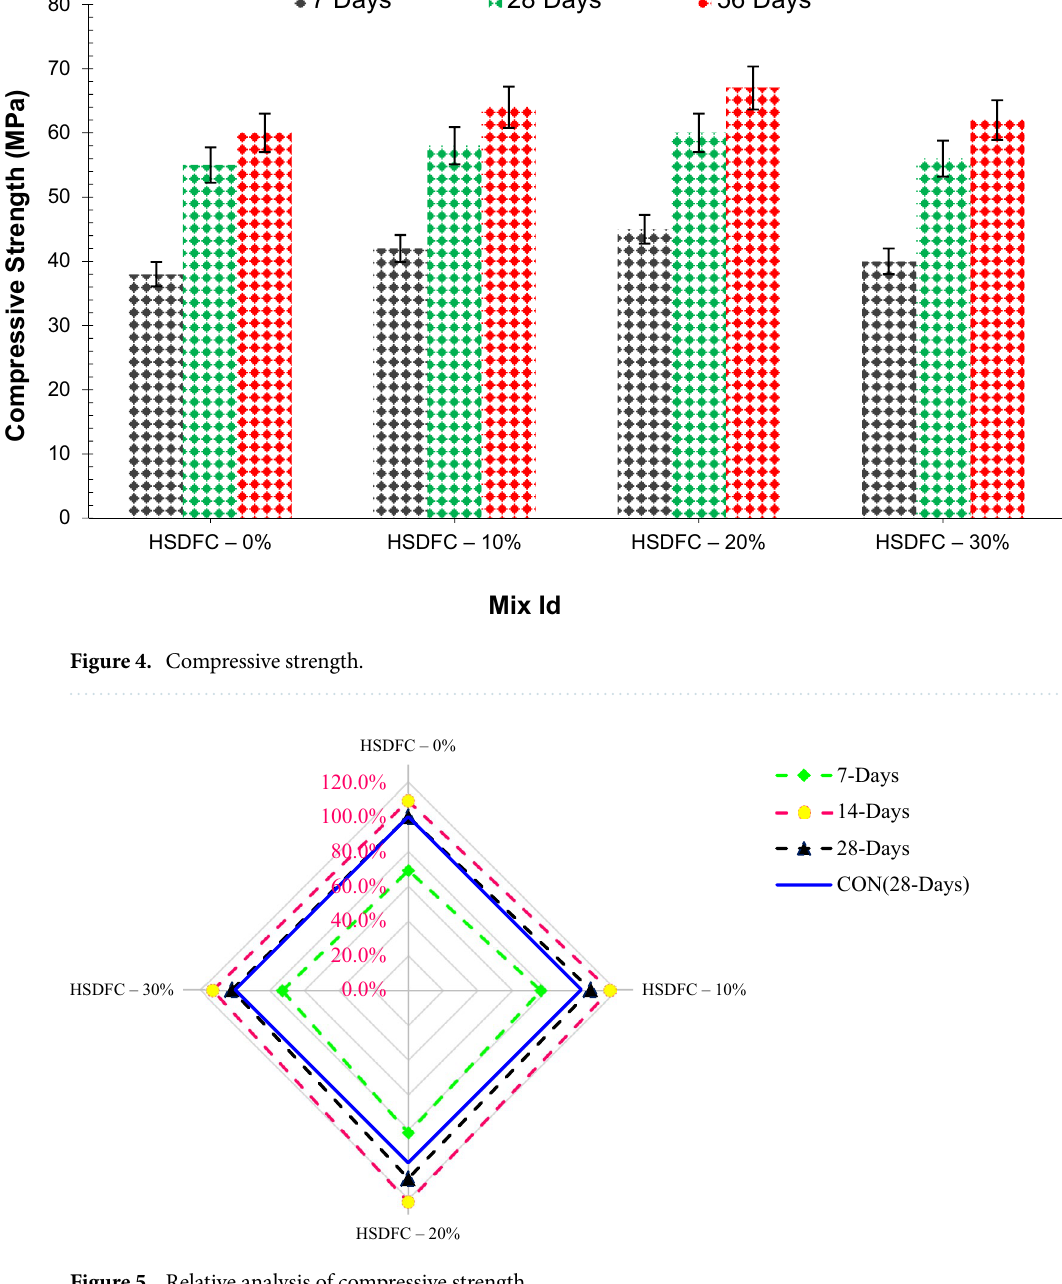
Figure 5. Relative analysis of compressive